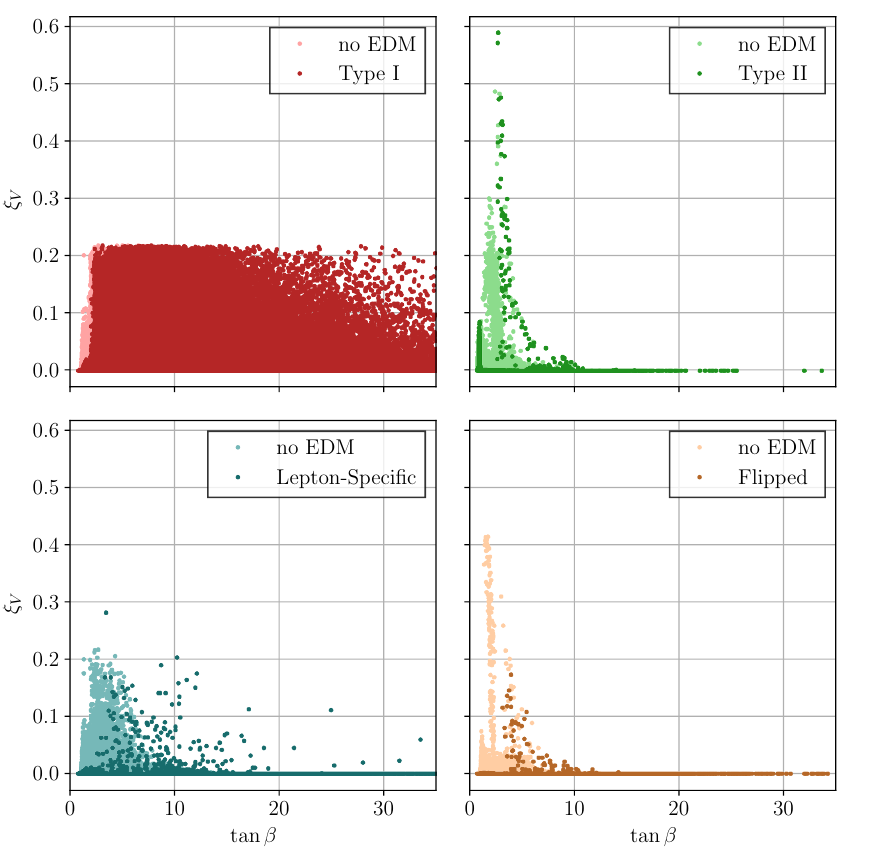
Figure 13 . The CP-violating parameter (cid:24) V as a function of tan (cid:12) for Type I (top left), Type II (top right), Lepton-Speci(cid:12)c (bottom left) and Flipped (bottom right). The lighter points have passed all the constraints except for the EDM bounds while the darker points have passed all